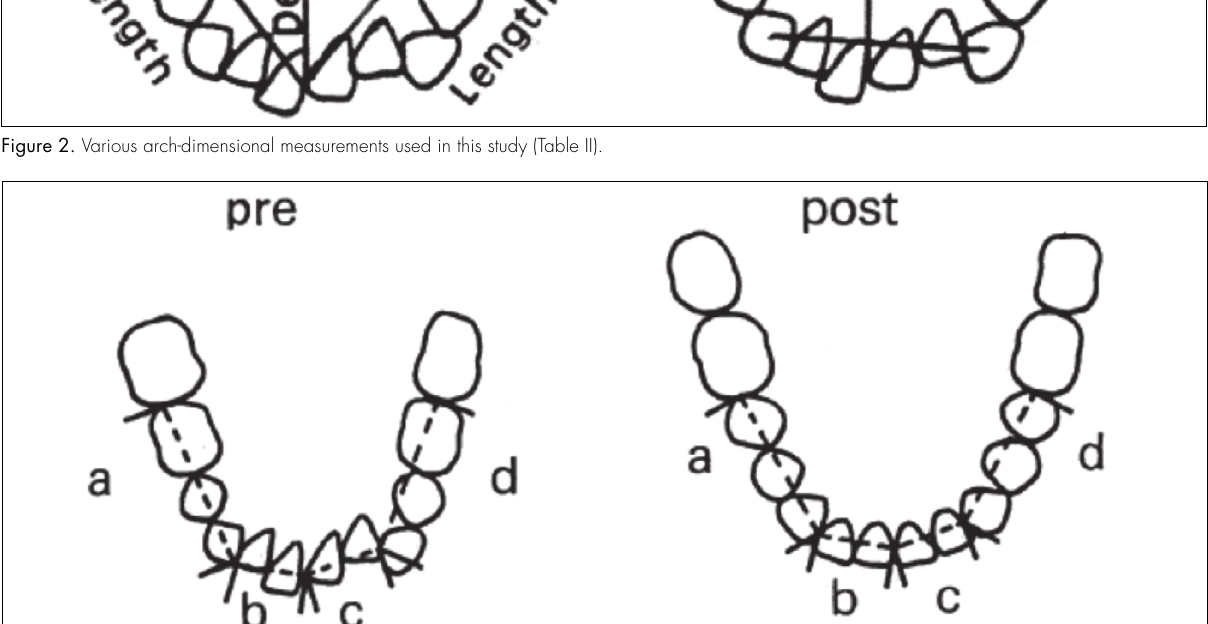
Figure 3. Calculation of space required using Proffit’s segmental method (a and d, posterior segments; b and c, anterior